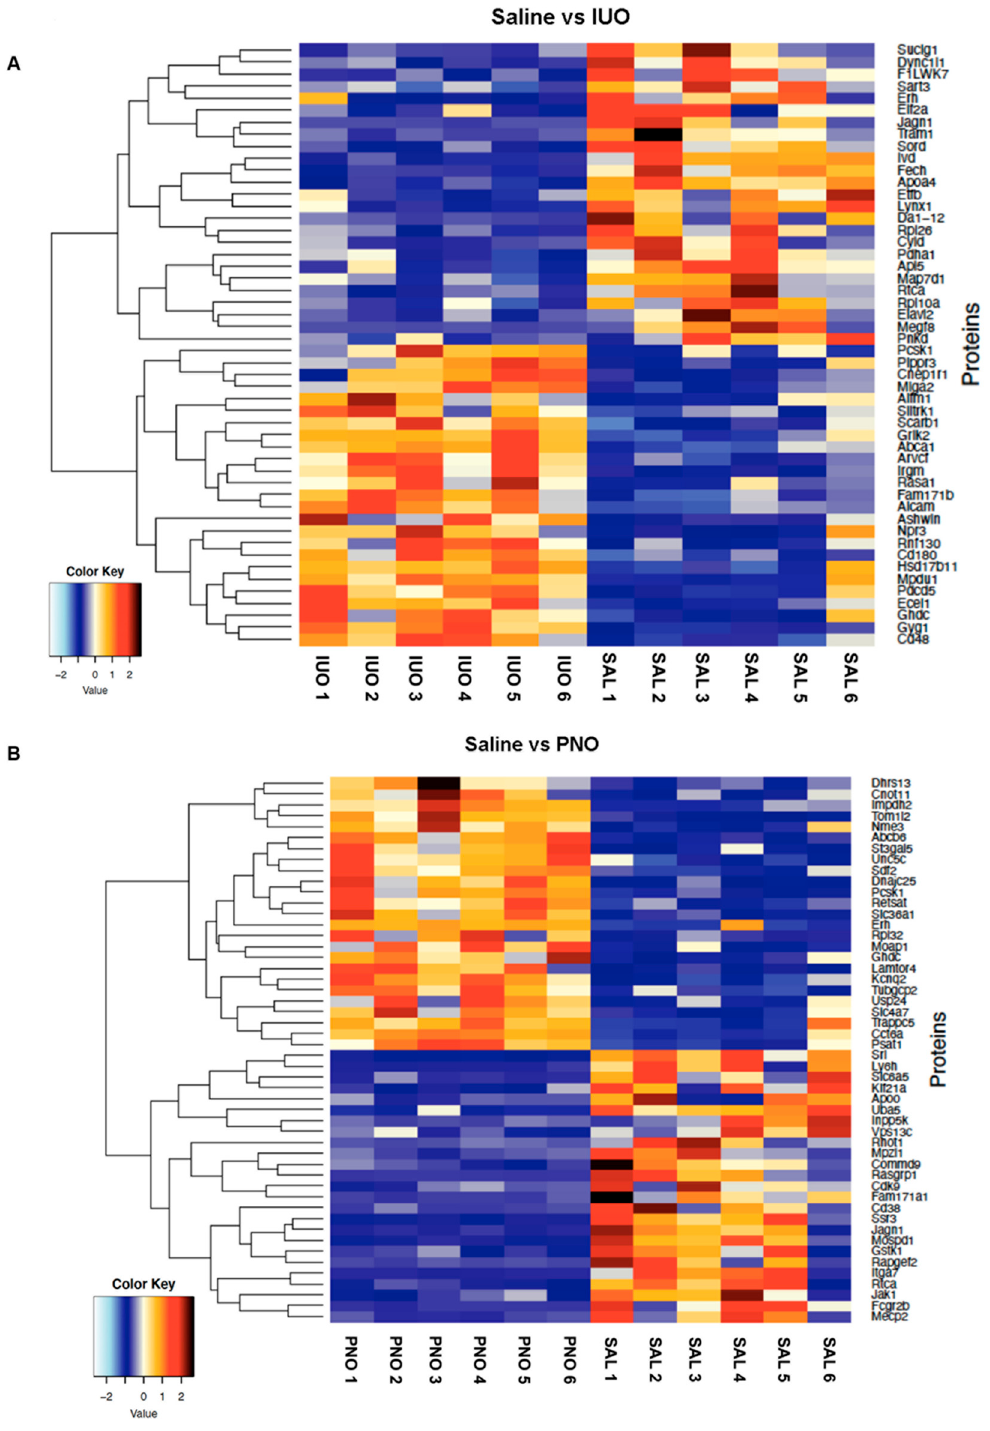
Figure 3. Heatmap showing the top differentially expressed SV proteins between IUO ( A ) and PNO ( B ) groups compared to the saline.